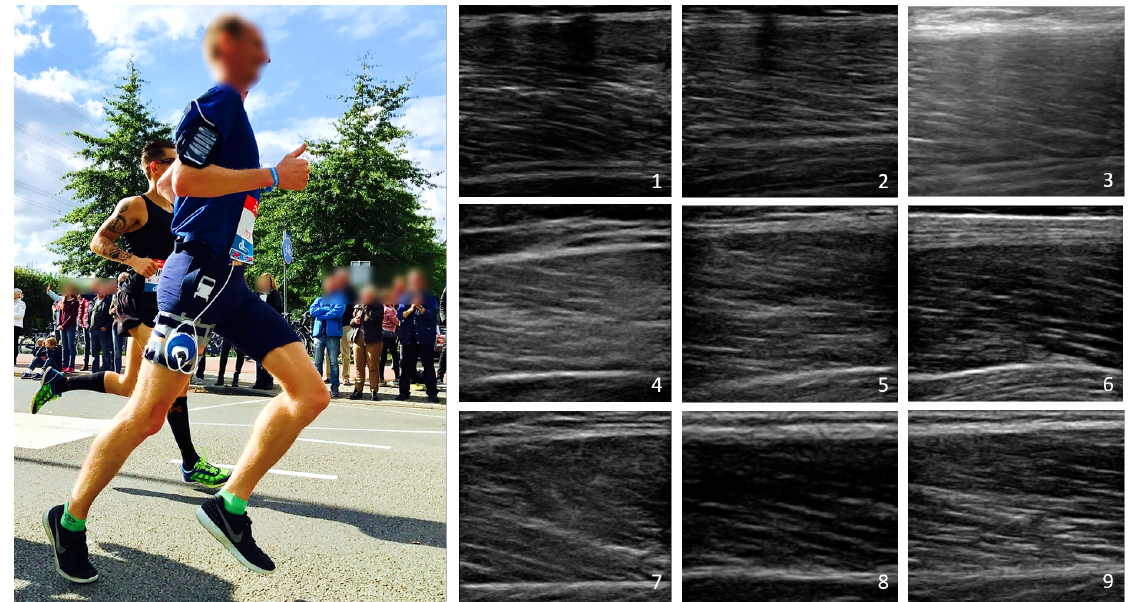
Figure 1. Experimental set-up of the endurance runners. ( Left ) The transducer is fixated onto the upper leg to image the belly of the vastus lateralis muscle in the longitudinal direction. The transducer is connected to a mobile phone, which is attached to the upper arm of the volunteer. ( Right ) A representative ultrasound image obtained at the 5th km of all included volunteers.